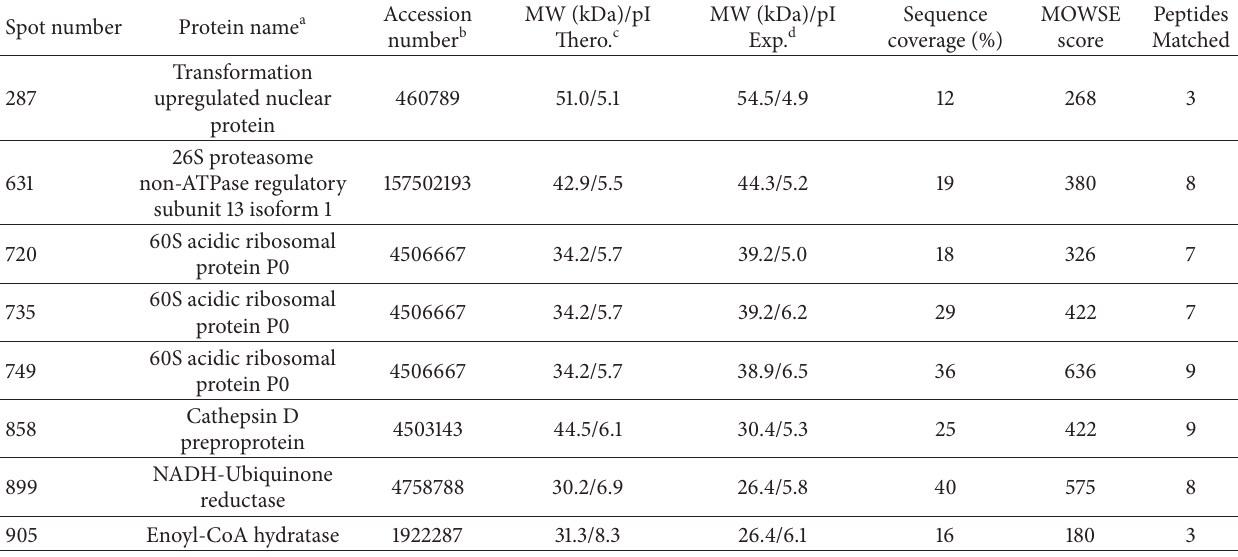
Table 1: Identification of arsenic-modulated proteins with